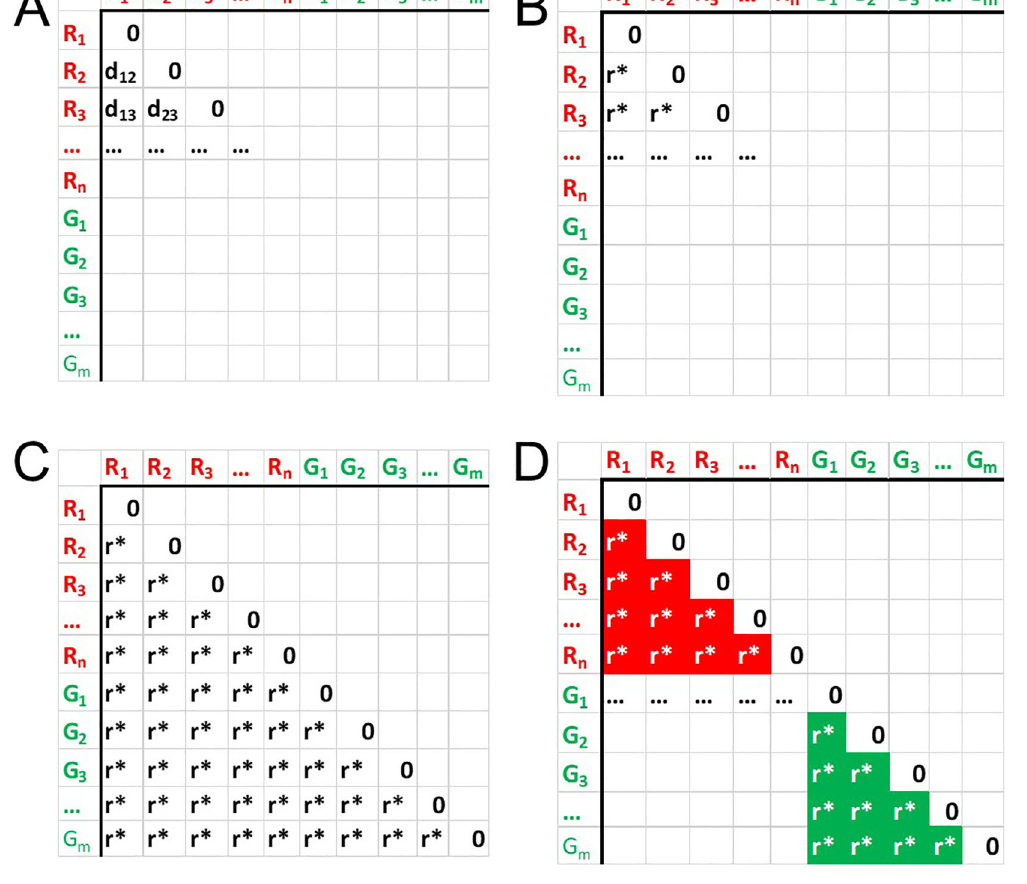
Figure 1. Distances ranking procedure A: Distance matrix structure. B: each distance element d pq is substituted with corresponding rank value. C: Repeating the process for all elements of the distance matrix. D: Sub-setting in-class ranks corresponding to in-class distance